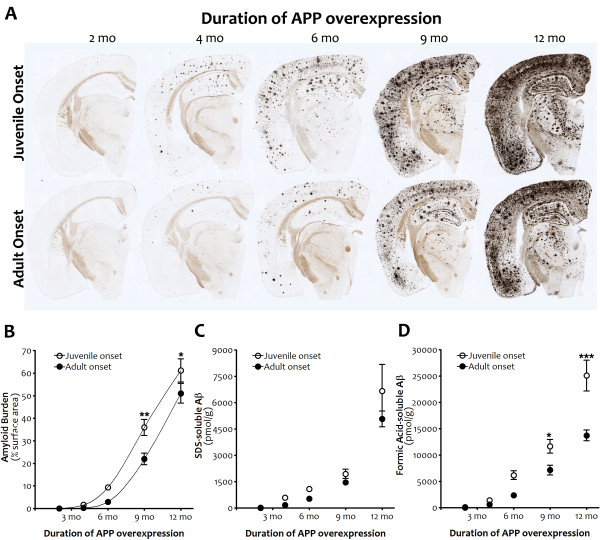
Amyloid burden and Aβ levels are slightly delayed by adult onset APP overexpression. A, Silver staining shows forebrain amyloid burden after 2, 4, 6, 9 and 12 mo of transgenic APP overexpression following juvenile (top row) or adult onset (bottom row). B, Quantitation of cortical amyloid burden from silver-stained sections demonstrates that delaying APP overexpression slows initiation of the exponential phase of plaque deposition (p < .001), although once underway the rate of amyloid accumulation is similar in both groups. Post hoc comparisons indicate significant differences in amyloid burden at 9 mo (**p < 0.01) and 12 mo (*p < 0.05) of APP overexpression. n = 3-4 per genotype at each time point. C, D Biochemical measures of Aβ concentration parallel histological measures of amyloid load. After equivalent durations of APP overexpression, adult onset is associated with lower levels of both SDS- and FA-soluble Aβ (Aβ 40 plus 42; p < 0.05 (SDS), p < 0.0001 (FA)). Additionally, the rate of change in FA-soluble Aβ is slower following adult onset (p < 0.001). Post hoc comparisons indicate significant differences in FA-soluble Aβ at 9 mo (*p < 0.05) and 12 mo (***p < 0.001) of APP overexpression. Graphs show mean ± SEM. n = 6-8 per genotype at each time point. Open symbols, juvenile onset; closed symbols, adult onset.